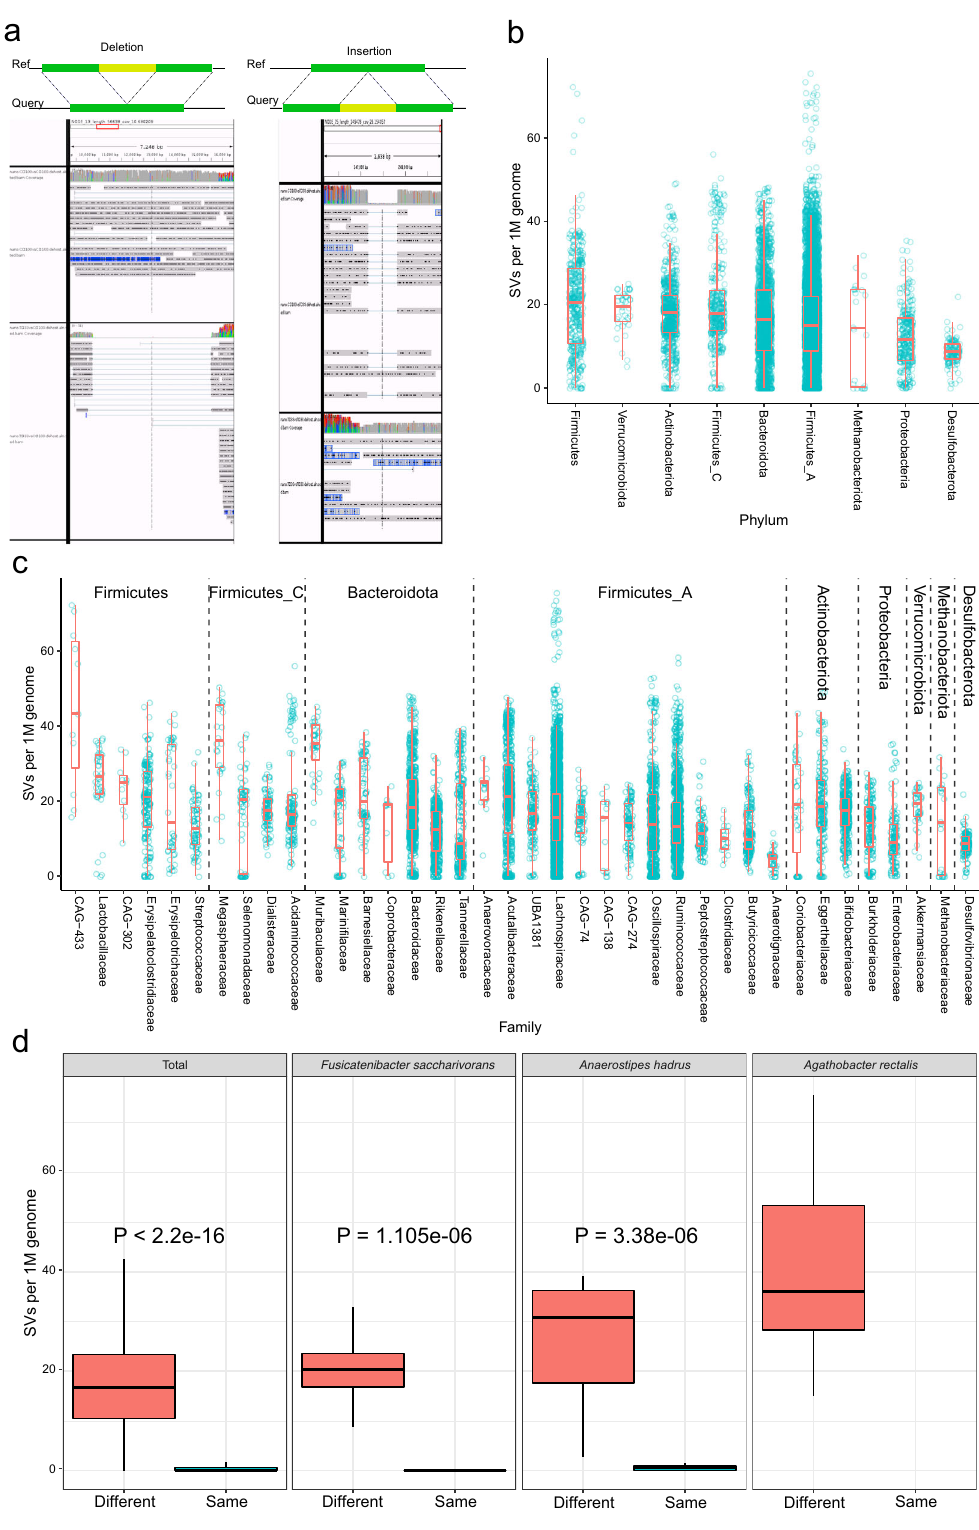
signi fi cant correlations (FDR < 0.1) to metabolites in the fecal, serum, or urine metabolome, a total of 889 SV-affected genes complicated bacterial-metabolite correlations (Fig. 3b, c, Supple- mentary Fig. 6, and Supplementary Data